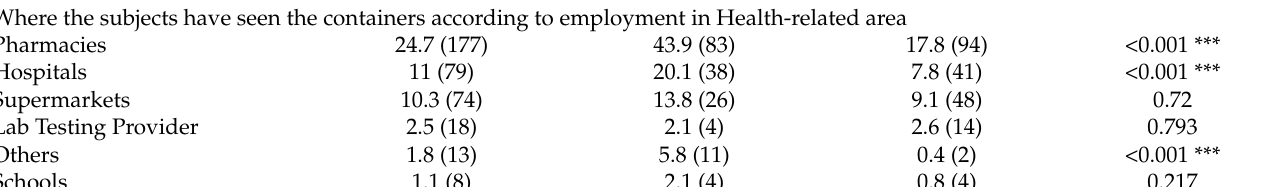
Table 2. Disposal techniques and knowledge of specific containers for the proper handling of medication, according to employment in the health-related area.